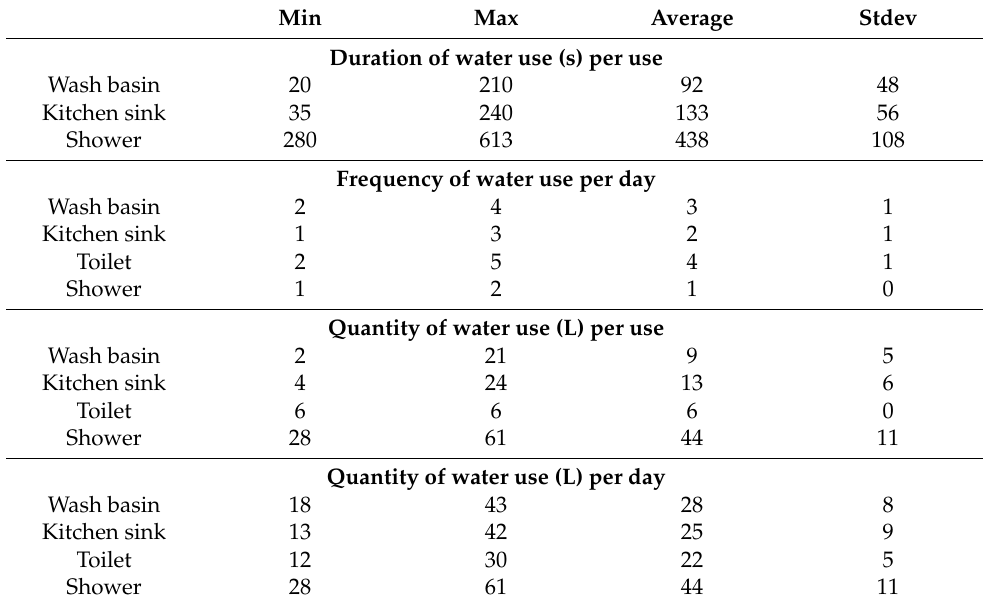
Table 1. Duration, frequency and quantity of water use at student residences.